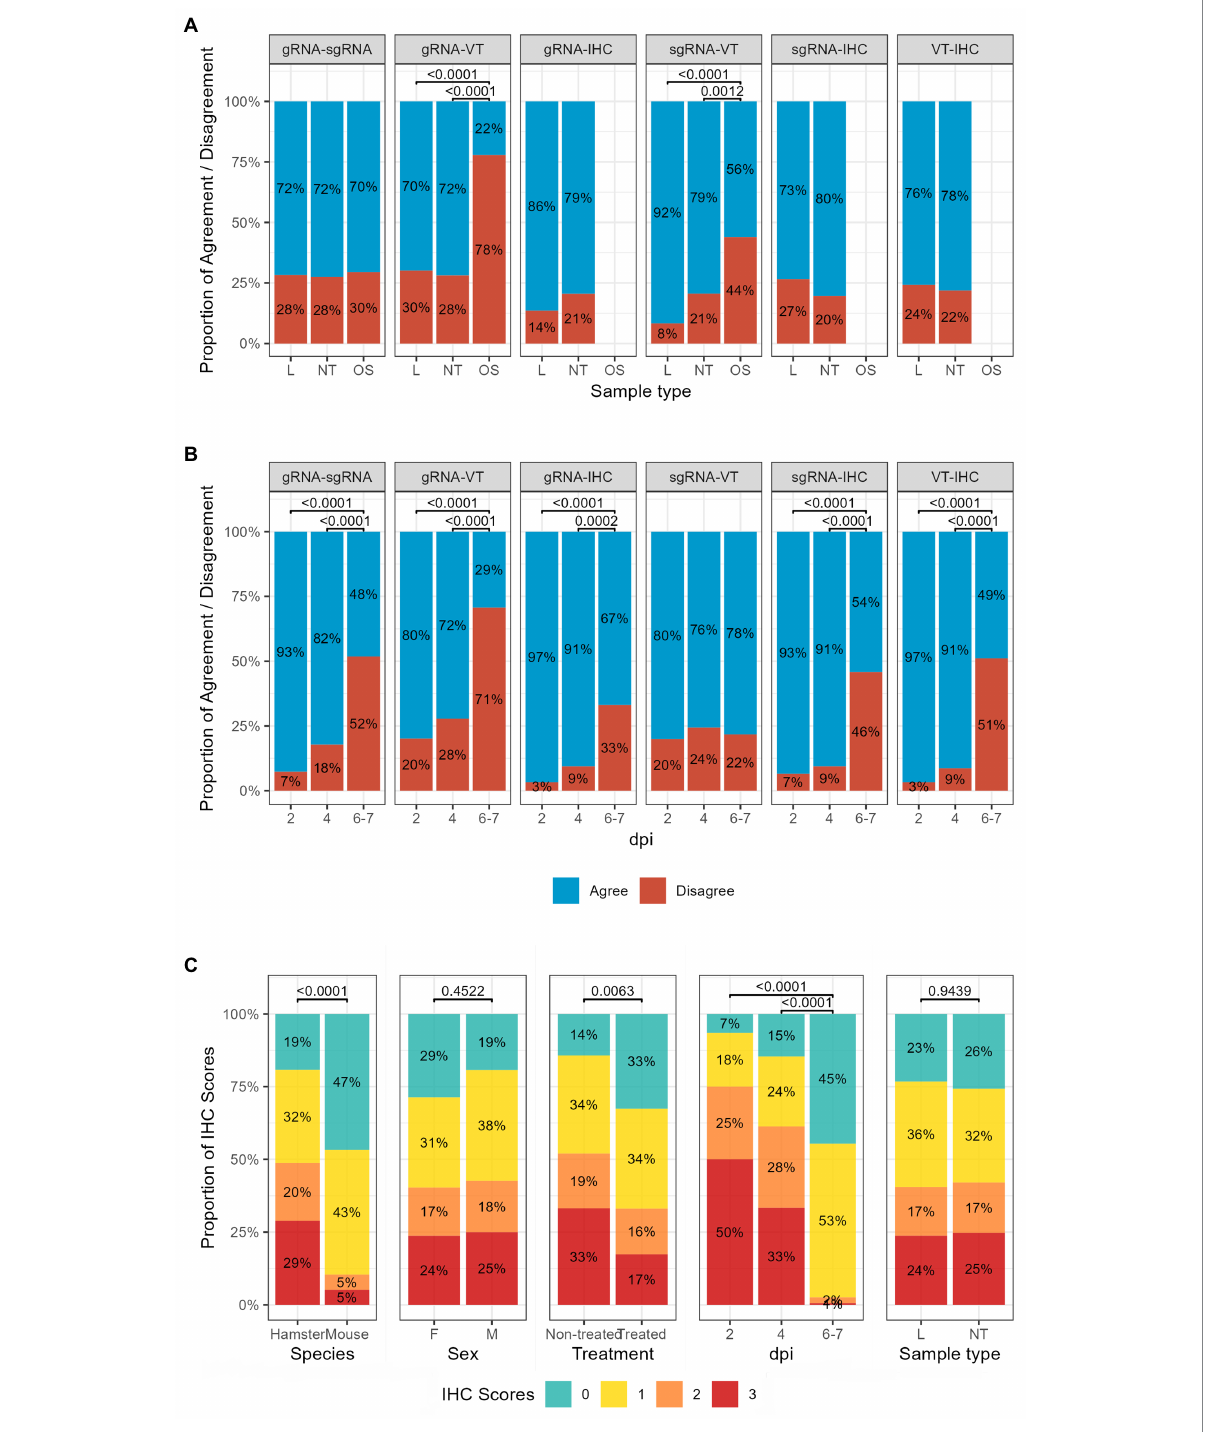
FIGURE 3 Influence of (A) sample type and (B) day post-infection on the percentage of agreement between techniques. (C) The proportion of IHC scores is different across time points, species, treatment status and sexes. Chi-squared test followed by Bonferroni correction; p -values lower than 0.05 are considered significant. L, lung; NT, nasal turbinate; OS, oropharyngeal swab; gRNA, genomic RNA; sgRNA, subgenomic RNA; IHC, immune histochemistry; dpi, day post-inoculation; F, females; M,